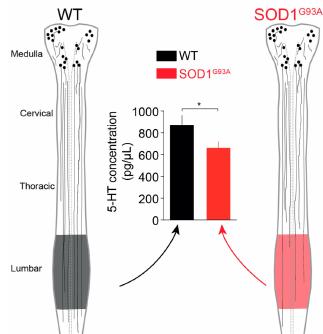
Figure 2. High-performance liquid chromatography (HPLC) assay of the monoamine 5-HT in E17.5 WT (black bar) and SOD1 G93A lumbar SCs (red bar). The schematic drawings on both sides of the graph depict the reduction in the density of descending 5-HT fibres from caudal raphe nuclei in the SC of SOD1 G93A mice compared to the SC of WT littermates. * p < 0.05, Mann-Whitney test.